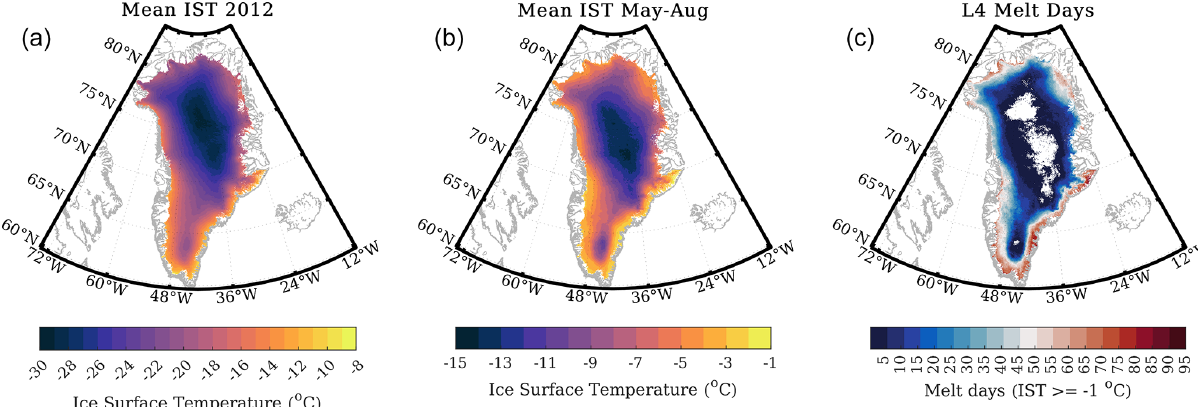
Figure 10. Mean IST for 2012 (a) and for the melt season May–August 2012 (b) and number of melt days during the melt season ( c , minimum 1d, white areas on the GIS indicate 0d) from the L4 IST